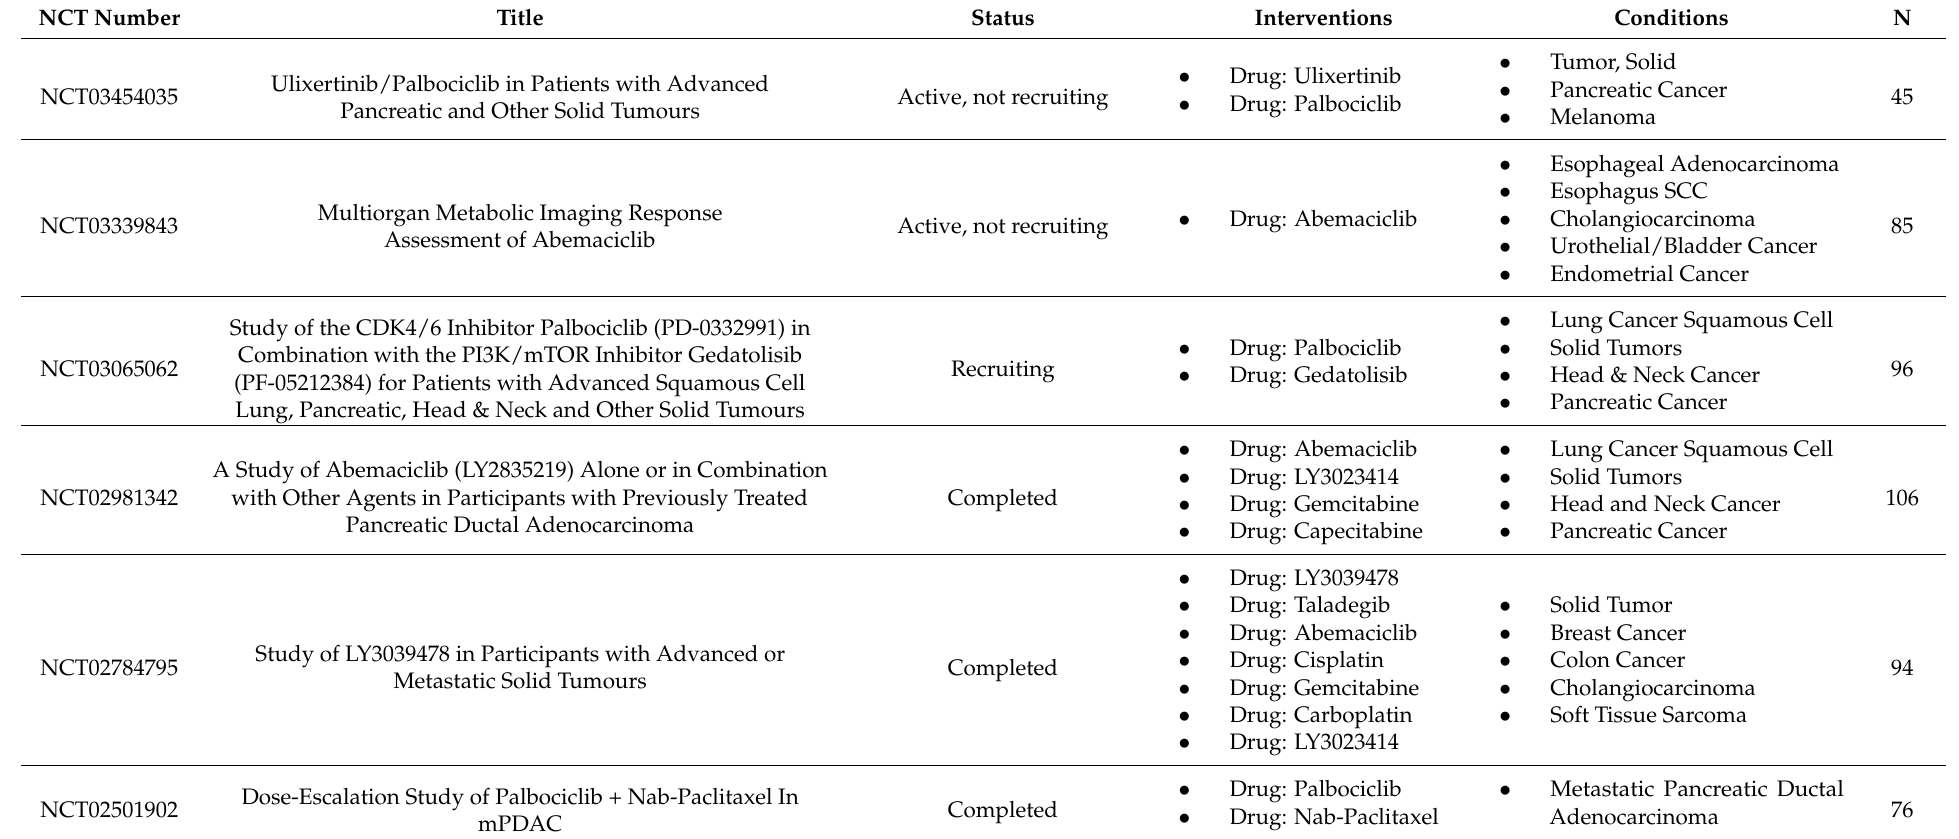
Table 1. Clinical trials evaluating the role CDK4/6is in pancreatobiliary cancers. Number of subjects